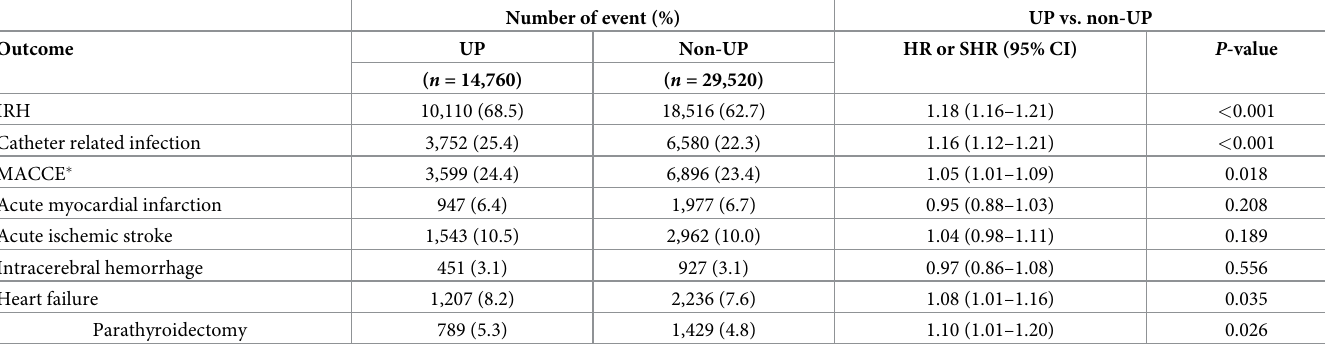
Table 2. Follow up outcome of in dialytic patients with and without uremic pruritus. Number of event (%) UP vs.